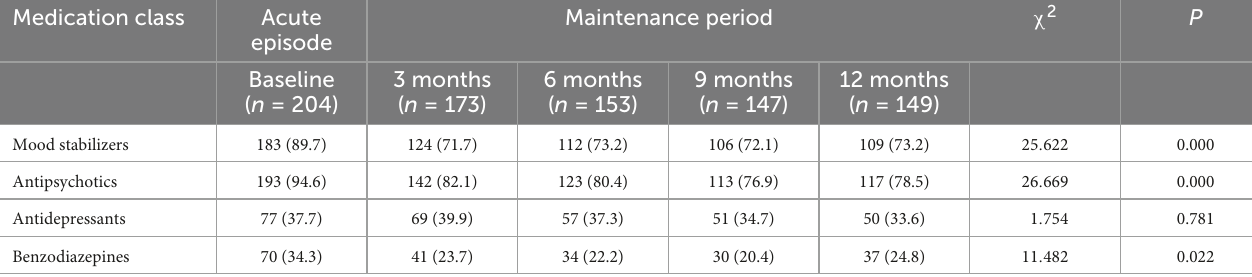
TABLE 2 Numbers of different medication classes used in the treatment of patients with bipolar